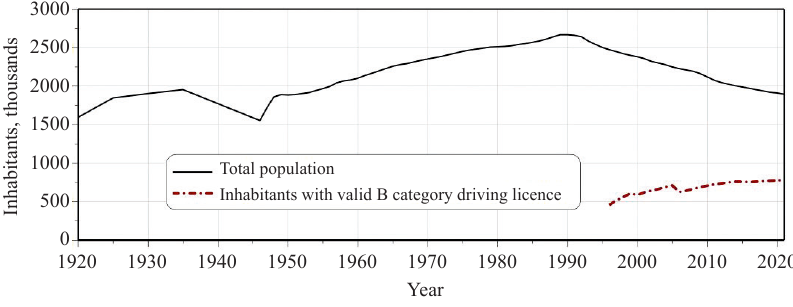
Figure 4. Population and number of valid category B driving licences in